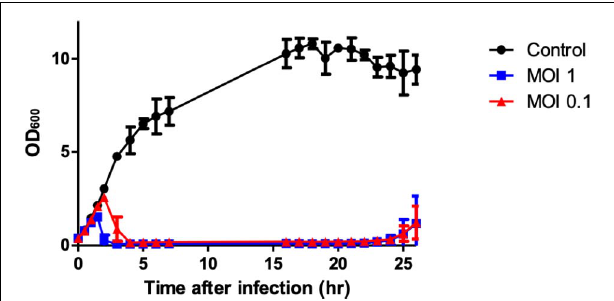
FIGURE 2 | Bacterial growth inhibition assay against S. aureus . Cells were prepared in three groups: the control group without phage ( • ) and the experimental group with phage ( (cid:4) , (cid:78) ; MOIs of 1 and 0.1, respectively). The data shown are the mean values from three independent measurements, and the error bars represent the standard